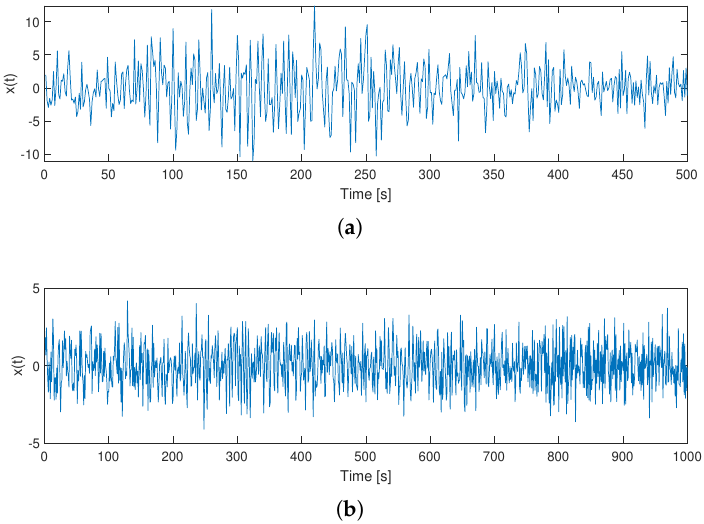
Figure 5. Time domain plots of the noisy signals. ( a ) The first signal. ( b ) The second signal.